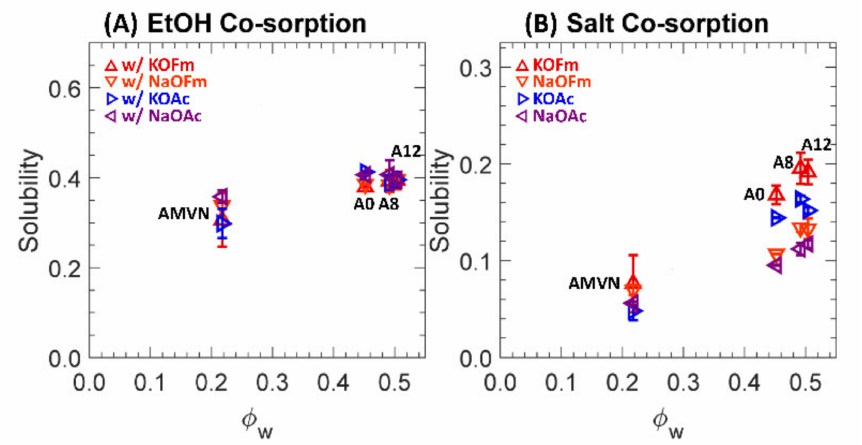
Figure 8. ( A ) Solubilities to EtOH in co-sorption with KOFm ( (cid:52) , red), NaOFm ( (cid:53) , orange), KOAc ( (cid:46) , blue) and NaOAc ( (cid:47) , purple). ( B ) Solubilities to KOFm ( (cid:52) , red), NaOFm ( (cid:53) , orange), KOAc ( (cid:46) , blue) and NaOAc ( (cid:47) , purple) in co-sorption with EtOH. Each data point is the average of 3 experiments, with error bars corresponding to the standard